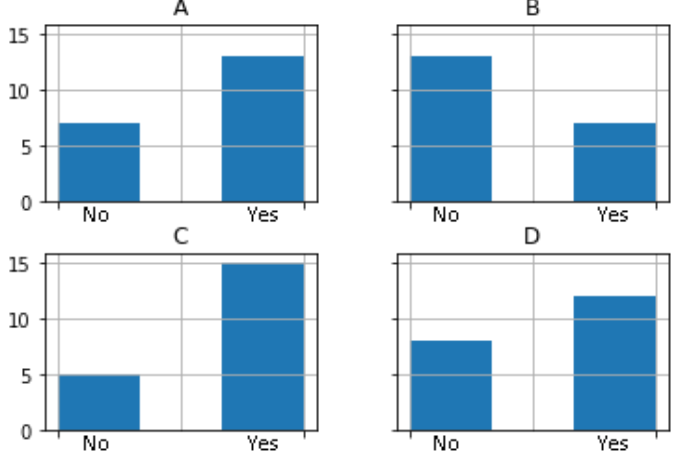
Figure 9. Evaluation of self-ability to help a collaborator: evaluation of self-ability to detect that a collaborator needs help with AggData ( A ) or with NoData ( B ); evaluation of self-ability to help a collaborator with AggData ( C ) or with NoData ( D